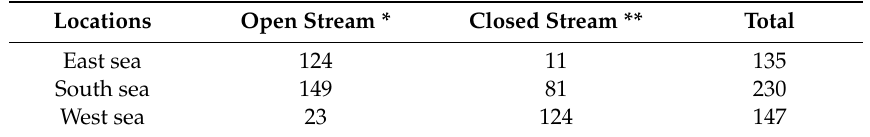
Table 1. Collection sites of water and epilithic diatoms in the downstream or estuary of Korean peninsula between 2009 and 2016.